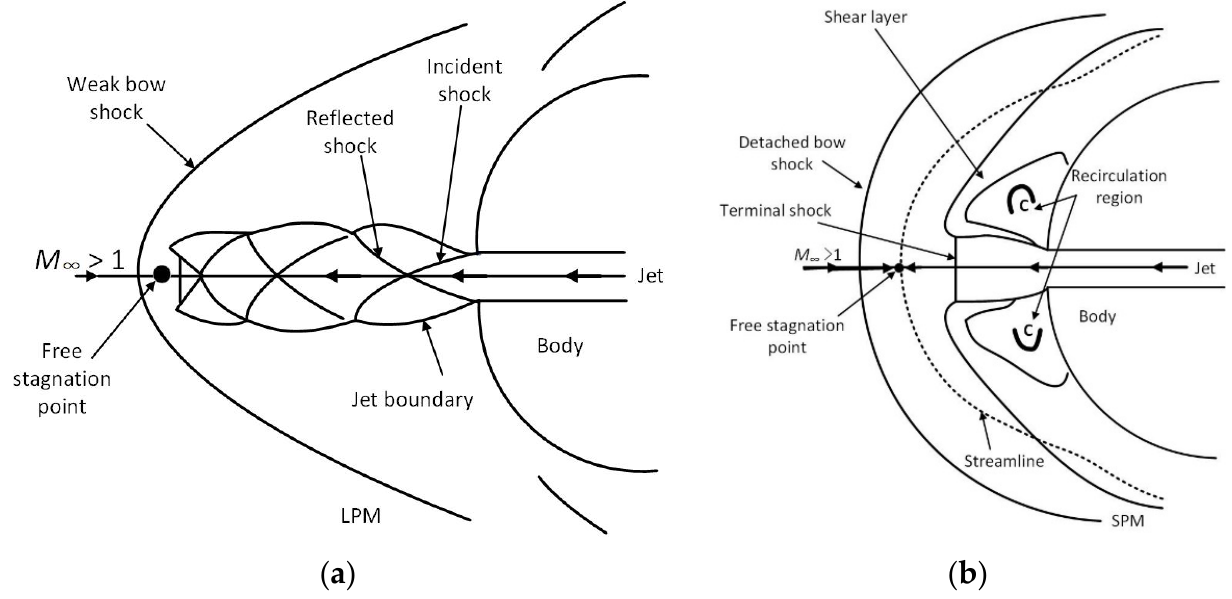
Figure 1. Schematic diagram of opposing jet structure: ( a ) Long penetration mode; ( b ) Short penetration mode.